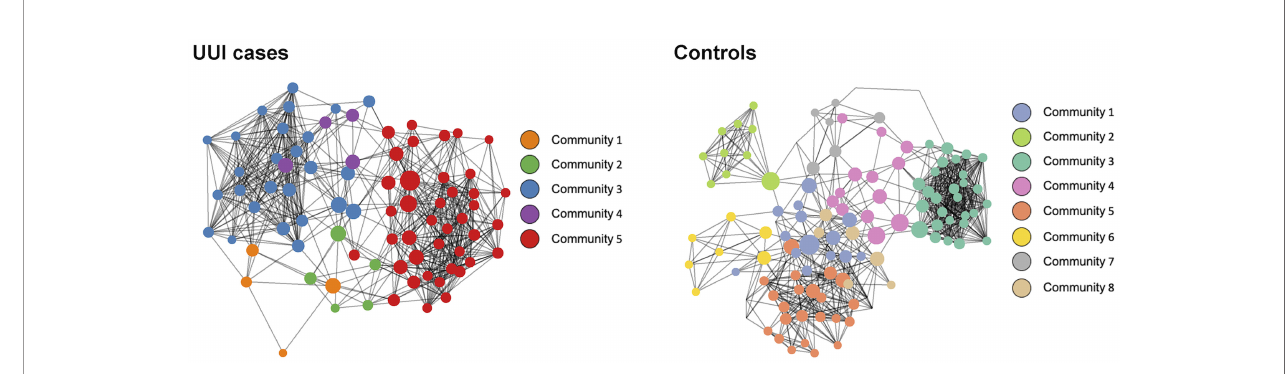
FIGURE 4 | Network visualization of bladder microbiomes. Each microbiome co-occurrence network, one for the UUI group (left) and one for the control group (right) consists of several bacterial genera (circles, colored by communities of bacteria identi fi ed using the InfoMap algorithm and sized by betweenness centrality value) that are connected to other bacterial genera by co-occurrence (edges/lines connecting circles, identi fi ed by SparCC correlation).